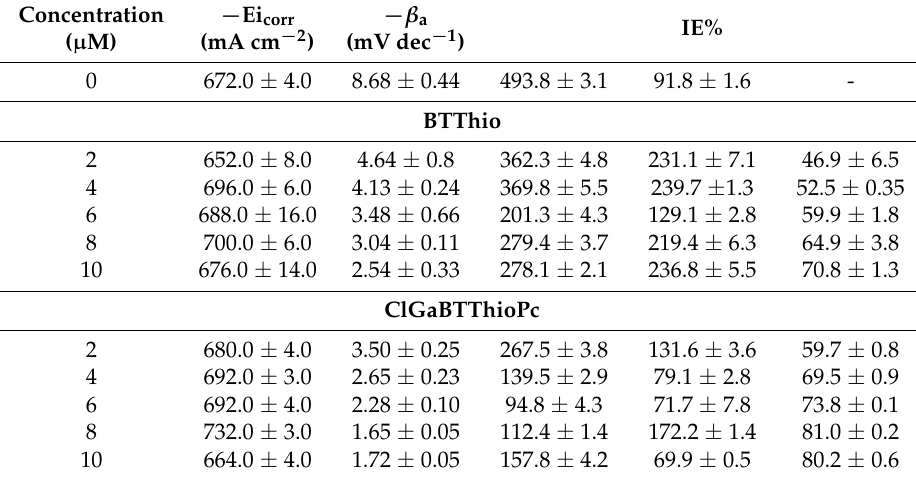
Table 1. Polarization parameters for aluminum in 1.0 M hydrochloric acid in the absence and presence of different inhibitor